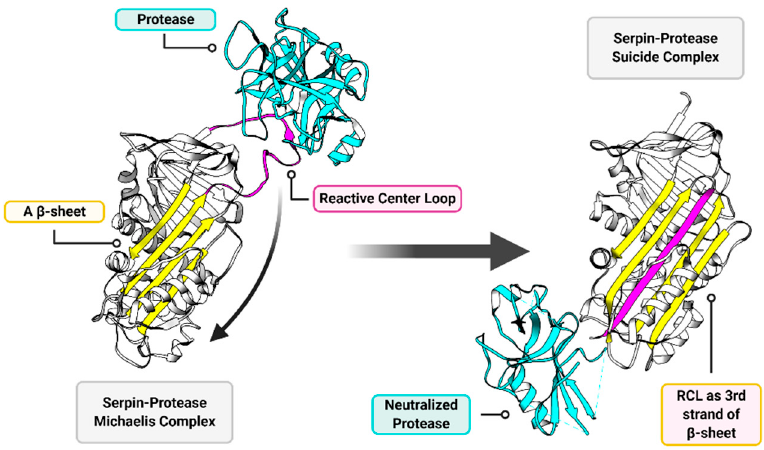
Figure 3. General overview of serpin function. The two major functional components of a serpin structure are the reactive center loop (RCL; magenta) and the A β -sheet (yellow). The RCL presents a protease cleavage site as a substrate to serine (and cysteine in cross-class serpins) proteases (cyan). When the target protease acts upon the RCL substrate a transient Michaelis complex forms (left), wherein the serpin and the protease are temporarily covalently bound to each other. When this Michaelis complex forms, the RCL performs a dramatic rearrangement and inserts as the third of five strands in the A β -sheet (right). The deformed and neutralized protease and serpin are permanently linked in a suicide complex, which then gets degraded. Structures are modeled on RSCB entries 1K9O (left) [36] and 1EZX (right) [35].